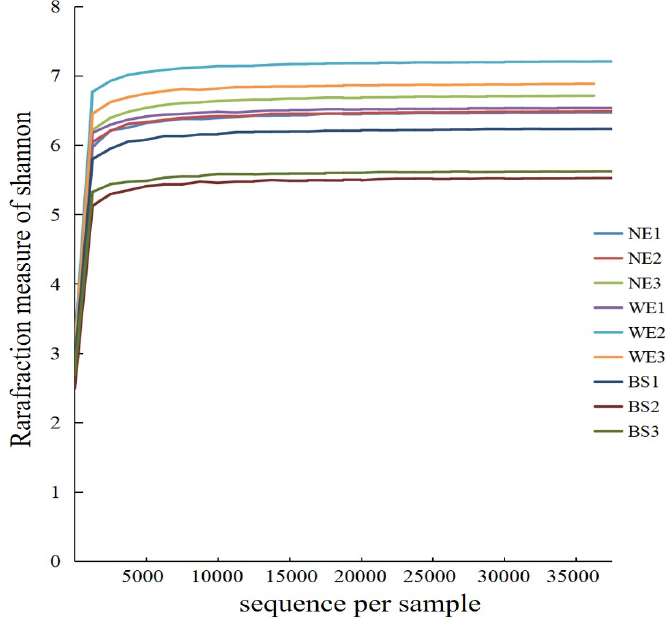
Figure 2. Rarefaction curves of fungal communities based on sequences per sample (label: 0.97). WE